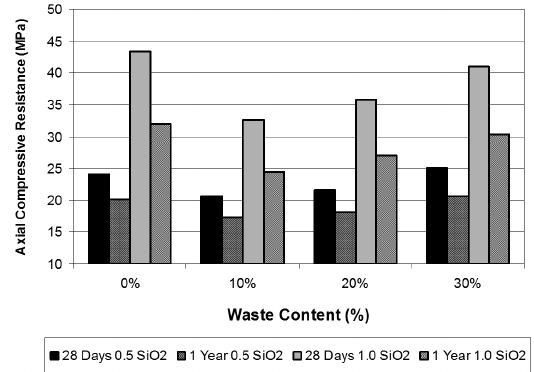
Figure 6. Variation in compressive strength of magnesium phosphate cement mortars containing grinding dust, artificially aged for a period equivalent to one year.